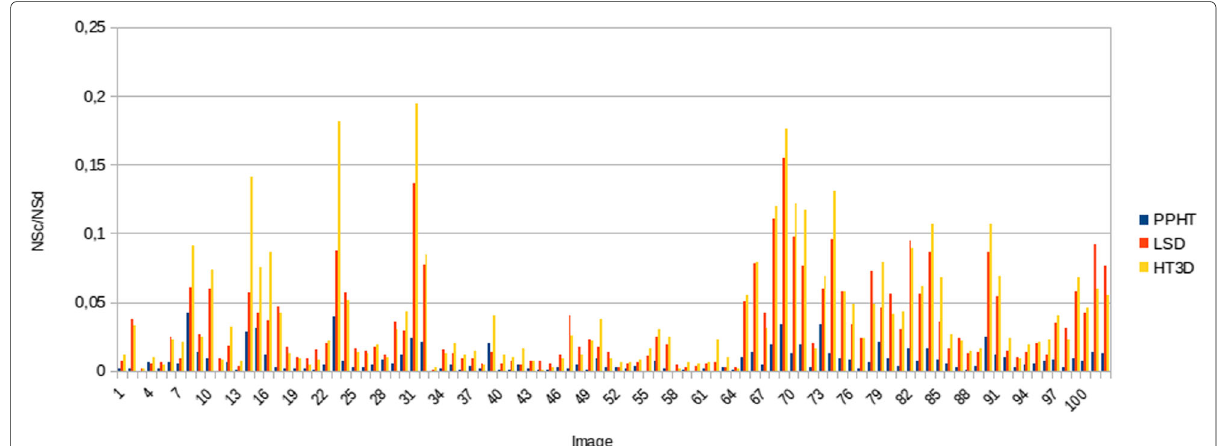
Fig. 23 Ratio between NS c (number of detected segments matching the ground truth data) and NS d (total number of detected segments) for the whole dataset considering d S = 3 (distance between ground truth and detected line segments). Higher values of this ratio can be observed in most of the test images for the proposed method when comparing with the other two approaches. This indicates a better performance of HT3D in relation to LSD and PPHT. In addition, the low values associated to PPHT are indicative of a high number of false detections